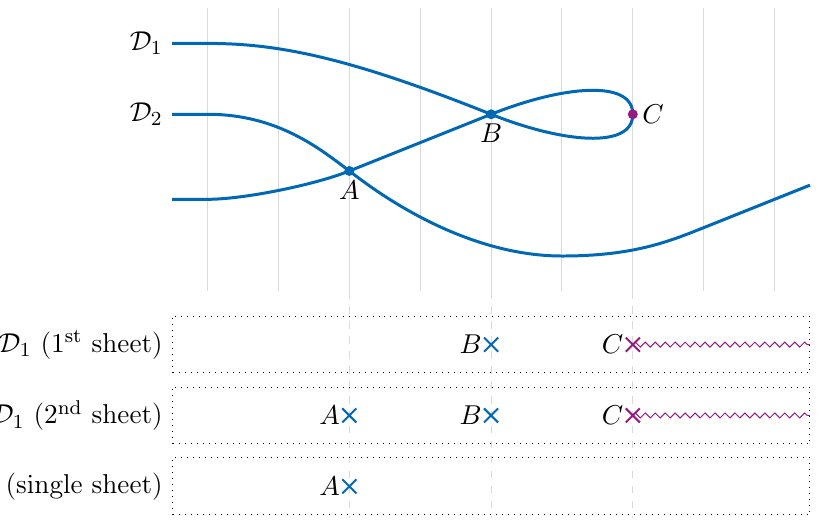
Figure 9 . An example of folding curves during a fibration/projection. The curve under consideration here consists of two irreducible components D and D . This figure shows three points that are at 1 2 singular configuration with respect to the fibration: intersection between two components ( A ), self- interaction of a single component ( B ), and a smooth point which appears singular under projection ( C ). In the region illustrated in the figure, D is folded into two sheets by the projection, while D 1 2 remains unfolded. In the space for D after projection, C turns into a branch point connecting the 1 two sheets, B turns into a pole on each sheet (hence effectively this creates two poles in the entire D 1 ), while A turns into a pole that is present only on one sheet. In the space for D 2 after projection, we only observe a pole from A